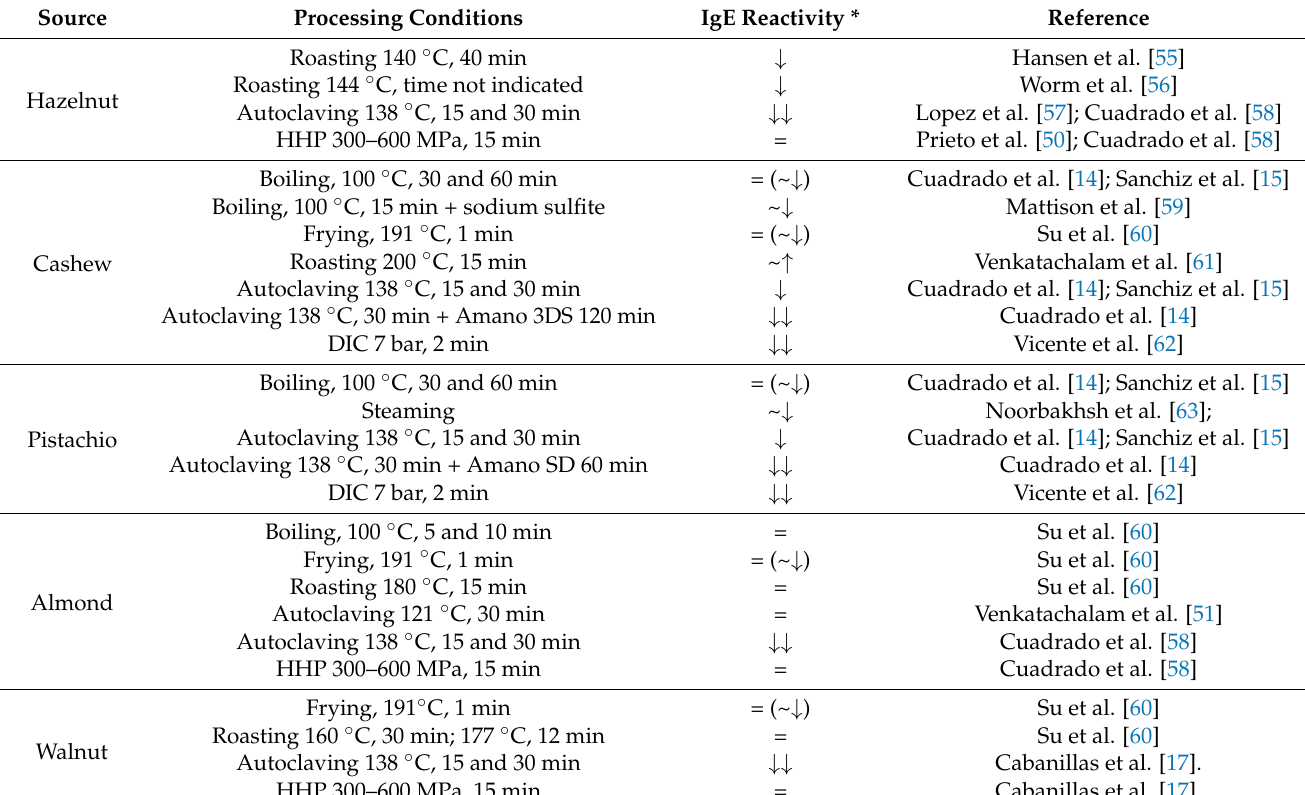
Table 2. Effects of processing on IgE immunoreactivity of nut